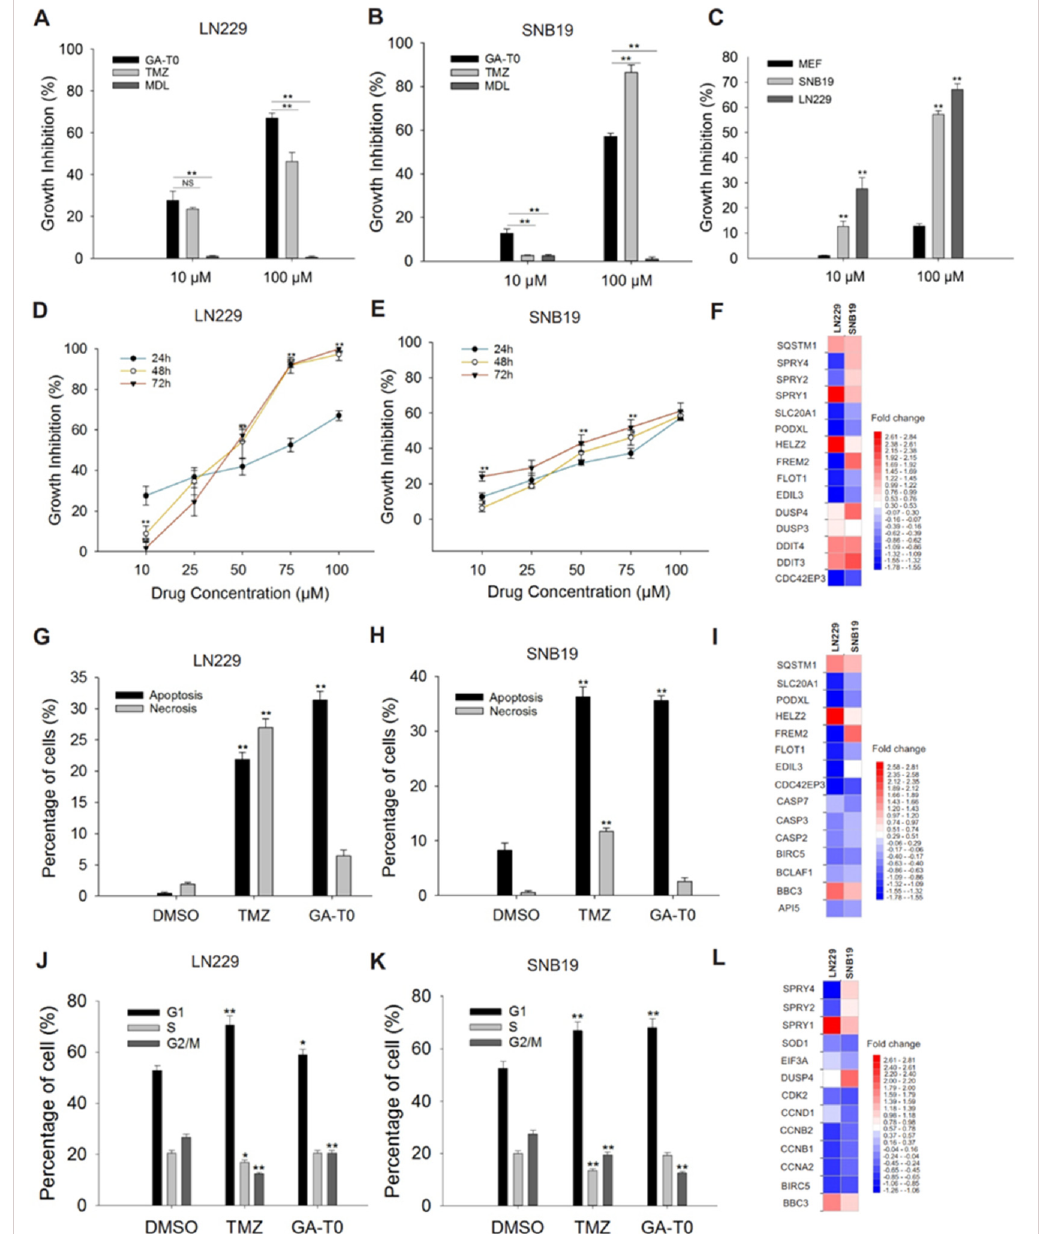
Figure 3. Effect of GA-T0 on glioblastoma cell growth, apoptosis, and the cell cycle. Percentage of cell growth inhibition at 10 µ M and 100 µ M concentrations of GA-T0, MDL 29,951, and TMZ in ( A ) LN229, ( B ) SNB19, and ( C ) non-tumor cells (MEF). Dose- and time-dependent effect of GA-T0 on ( D ) LN229 and ( E ) SNB19 at 10, 25, 50, 75, and 100 µ M for 24 h, 48 h, and 72 h, respectively. Top DEGs associated with ( F ) DNA damage. Percentage of apoptosis and necrosis in ( G ) LN229 and ( H ) SNB19 on treatment with DMSO, TMZ, and GA-T0 and ( I ) DEGs involved in apoptosis. Percentage of cells in different stages of the cell cycle (G1, S, and G2/M phase) in ( J ) LN229 and ( K ) SNB19 on treatment with DMSO, TMZ, and GA-T0 and ( L ) DEGs associated with cell cycle arrest. Data are the mean ± SD of six experiments using t-test analysis. Non-significant data are denoted by NS and significant data by asterisks (*, p < 0.05 and **, p <